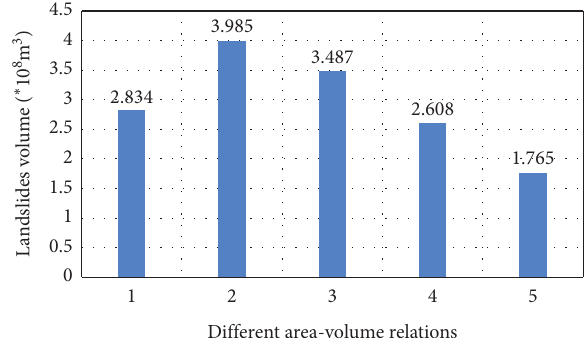
Figure 7: Calculated coseismic landslide volumes with values from the different area-volume relations (1: Larsen et al.; 2: Guzztti et al.; 3: Xu et al.; 4: Parker et al.; and 5: this